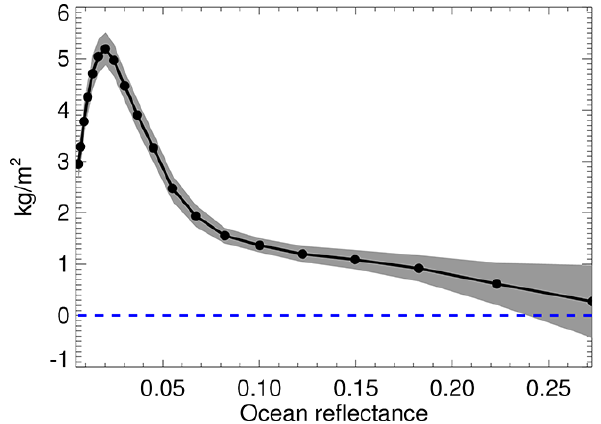
Figure 8. Difference of MERIS TCWV and SSM/I TCWV over ocean (MERIS – SSM/I) as a function of ocean surface reflectance, analysed from 1 month of collocated MERIS and SSM/I observa- tions (July 2007). Grey shaded area indicates standard deviation of bias, analysed from bootstrapping